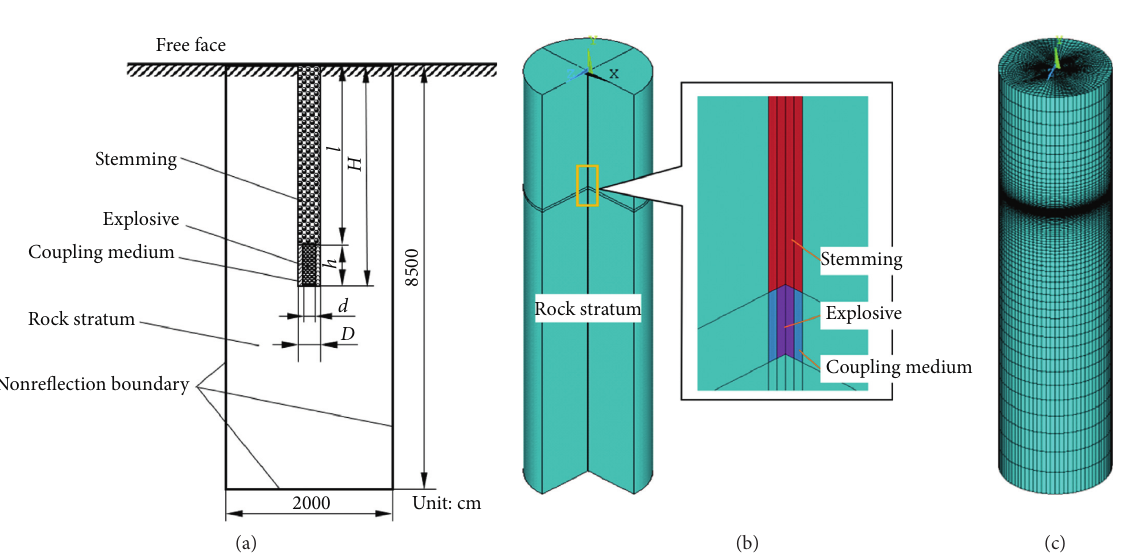
Figure 2: The numerical simulation model. (a) Size of the model. (b) 3/4 of the model and the charging constitution. (c) The numerical simulation model.